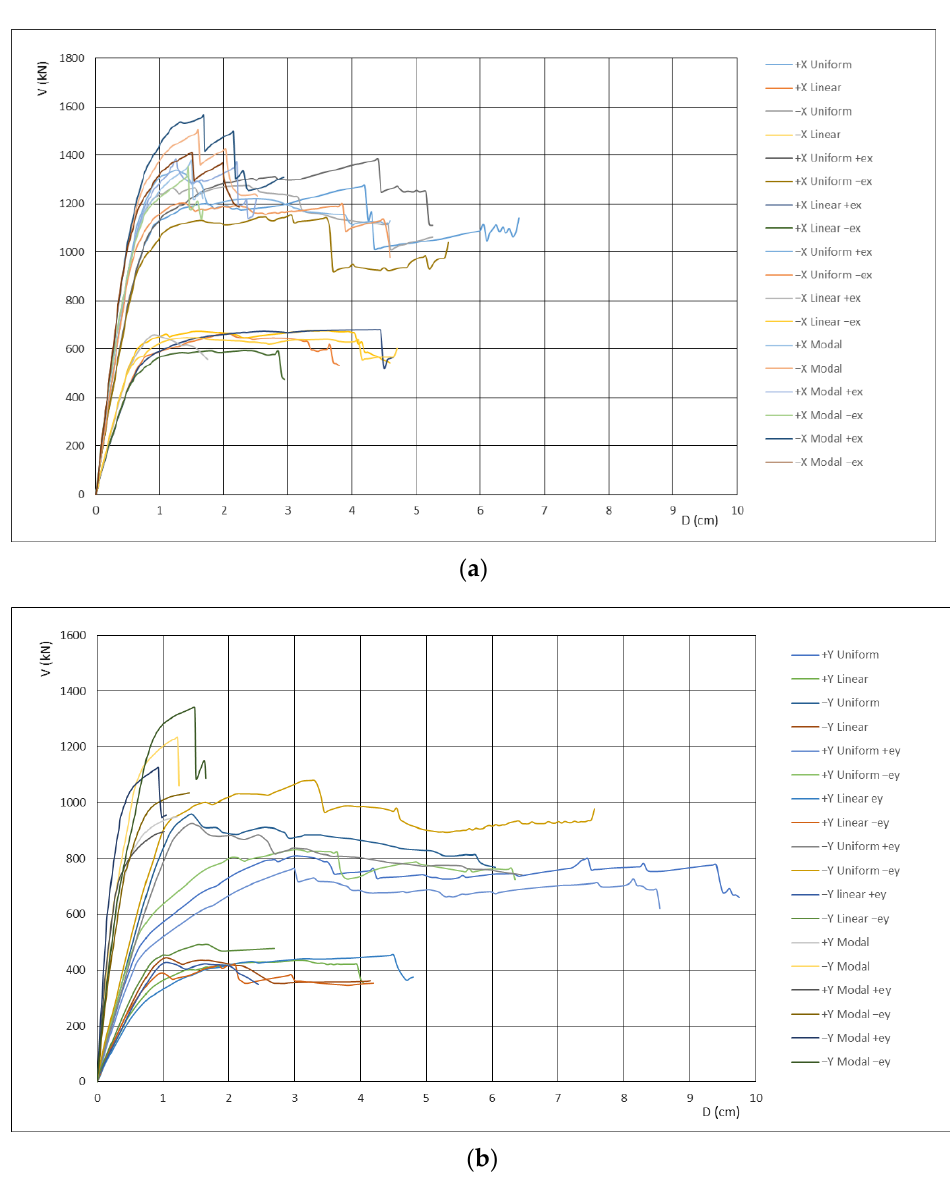
Figure 9. Pushover curves for the Cambi Tower: ( a ) x-direction; ( b )